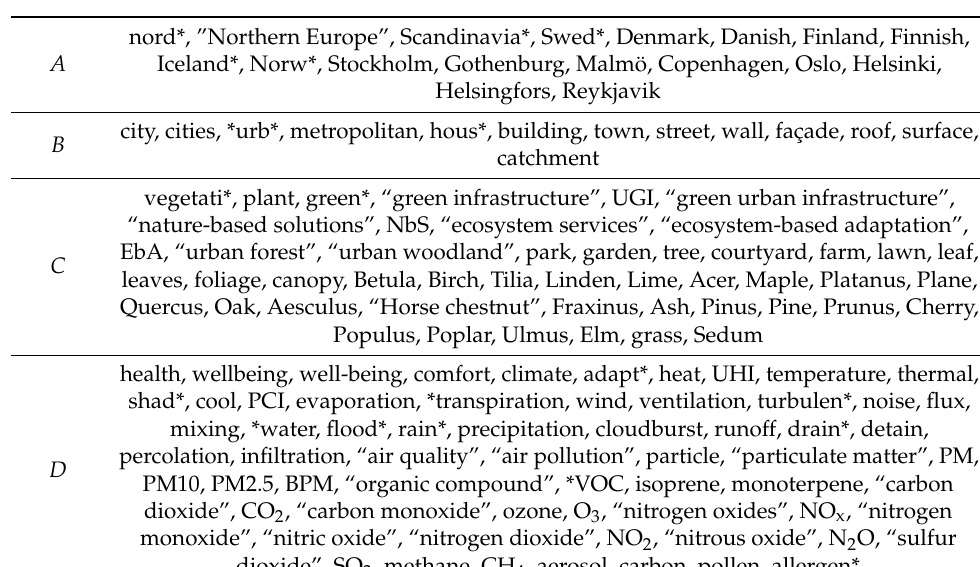
Table A1. The search string takes the general form A AND B AND C AND D , where A stands for keywords characterizing the geographical location, B is the spatial unit, C the UGI type, and D the topic. Keywords are separated by OR in the string, and * is a wildcard character.